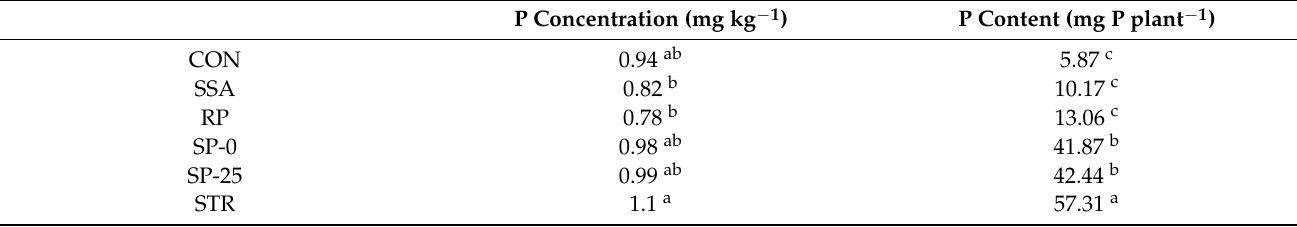
Table 5. Mean values of maize aboveground biomass P concentration (mg kg − 1 ) and P content (mg P plant − 1 ) after 10 weeks of growth. The same letters indicate no significant differences between the treatments ( n = 4, Tukey ´ s HSD test ( α = 0.05)). For fertilizer abbreviations, see Table